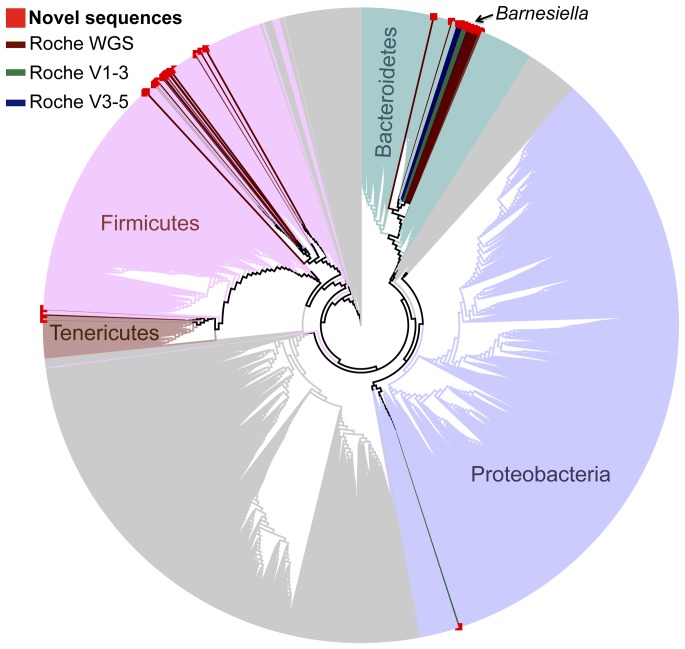
Taxonomic distribution of novel reads.Novel reads from each dataset (dark colored branches, see legend) were inserted into the Silva reference tree with RAxML and are marked with a red box at the end of the leaf. Novel reads cluster into phyla that are typically found in stool samples (light colored branches, as labeled); all remaining phyla are shown in gray. The black arrow indicates the group of reads identified as the genus Barnesiella.